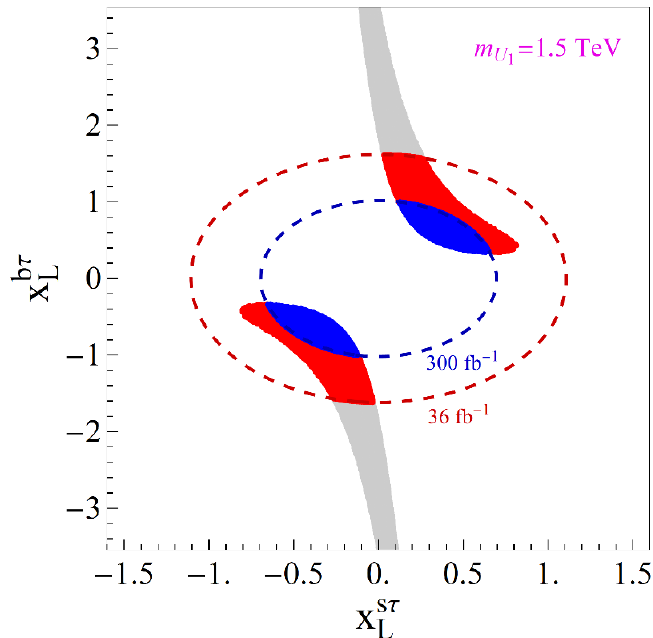
Figure 7 . The correlation between the couplings x s(cid:28) for m U = 1 : 5 TeV. Gray points are excluded by current LHC data (36 fb (cid:0) 1 ) on pp ! ‘‘ ( ‘ = (cid:22); (cid:28) ). 1 The future LHC sensitivity is depicted by the red points, which were obtained by extrapolating current data to 300 fb (cid:0) 1 , as discussed in section 4.2. Blue points are allowed by all constraints, including the extrapolated LHC results to 300 fb (cid:0) 1 .